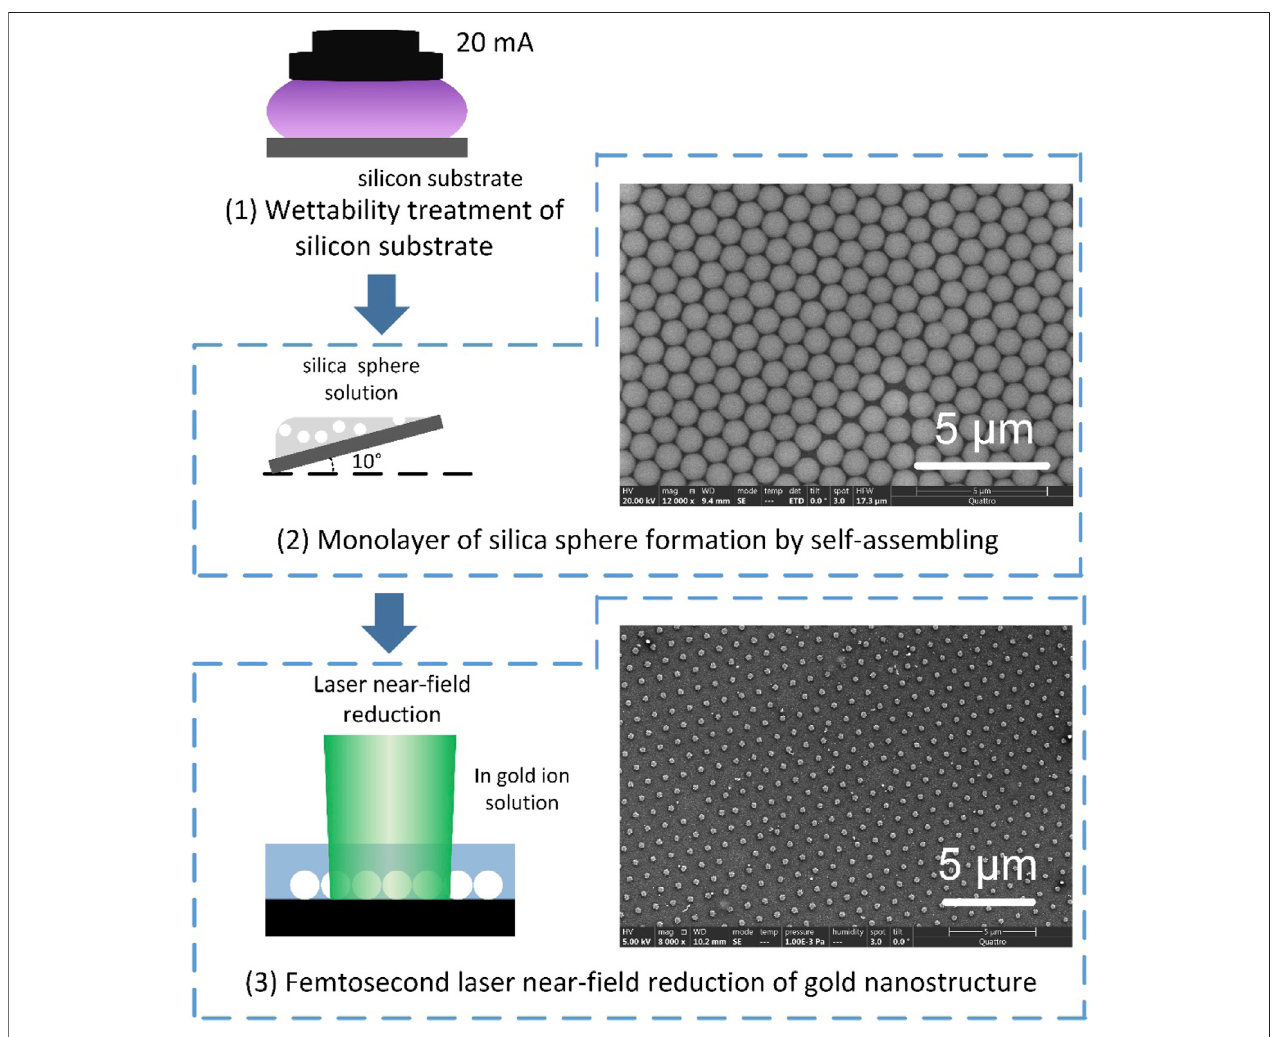
FIGURE1| Fabricationprocedureofthefemtosecondlasernear- fi eldreductionforformationofperiodicgoldnanostructureswithSEMmicrographsofsamplesat (2) self-assembling of monolayer of silica sphere array and (3) formation of 2D periodic gold nanostrictures.